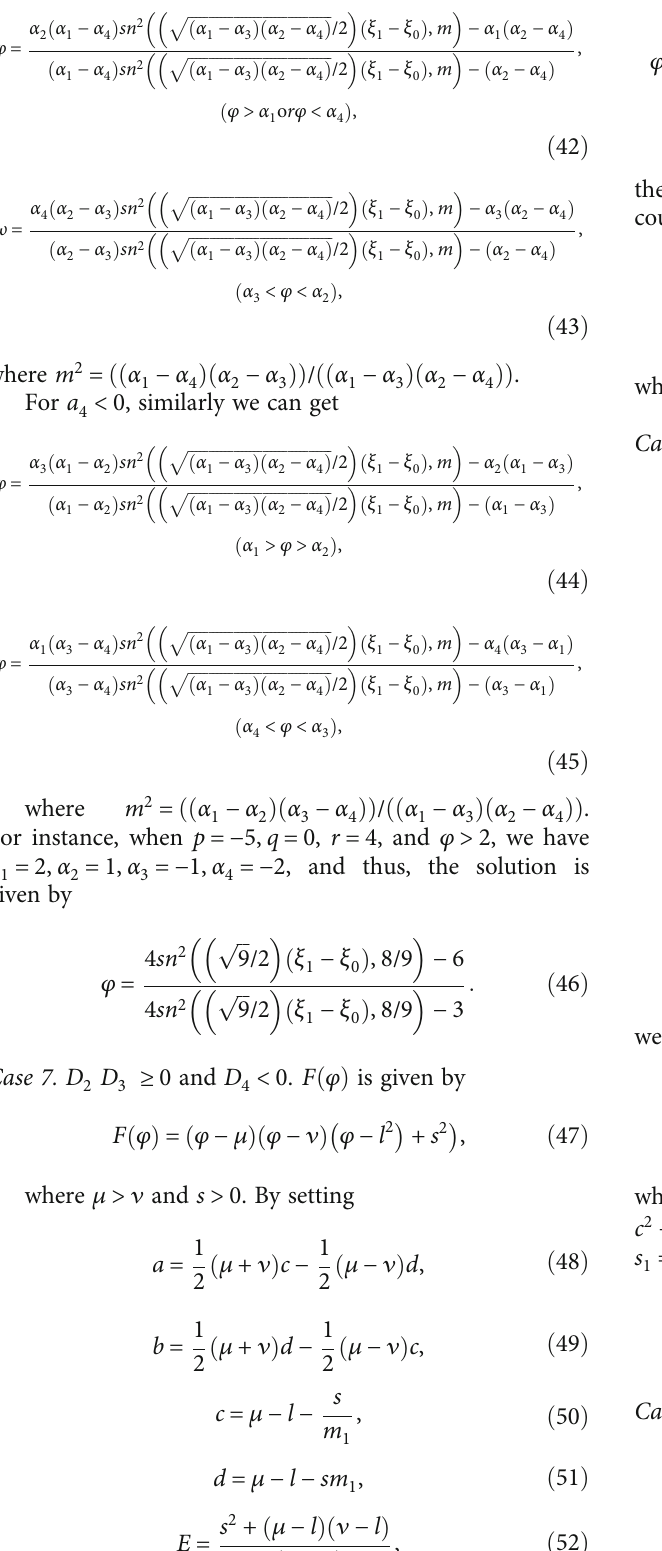
ffiffiffiffiffiffiffiffiffiffiffiffi p E 2 + 1